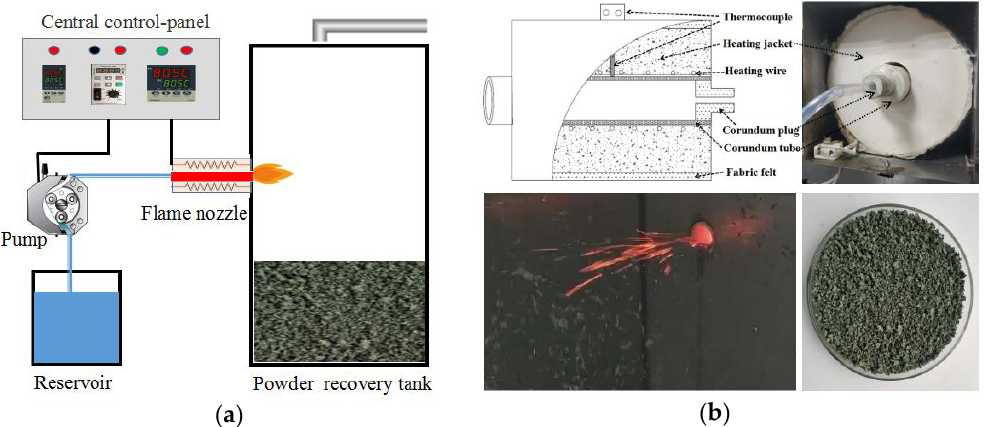
Figure 2. ( a ) Diagrammatic sketch of self-propagating combustion furnace. ( b ) More details about the improved solution combustion synthesis